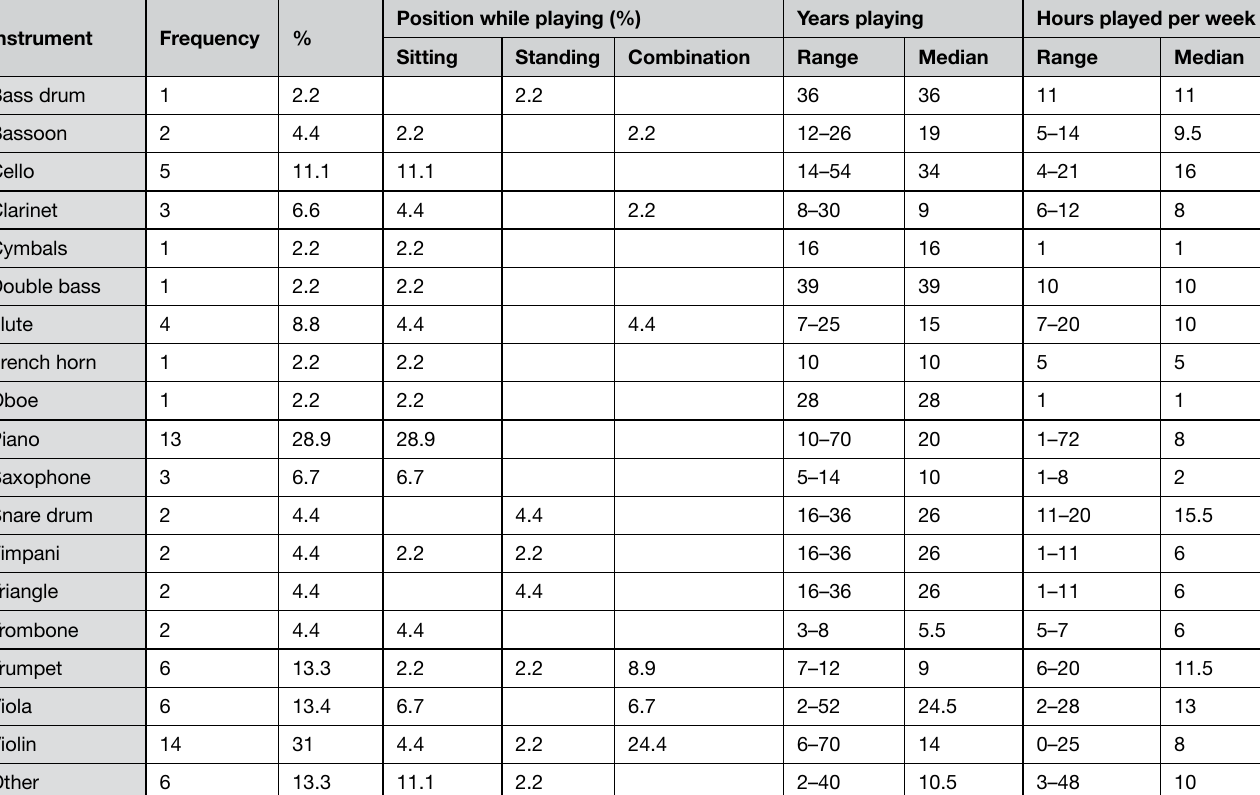
Table 1: The number of years participants played their instruments and number of hours per week spent on practicing.